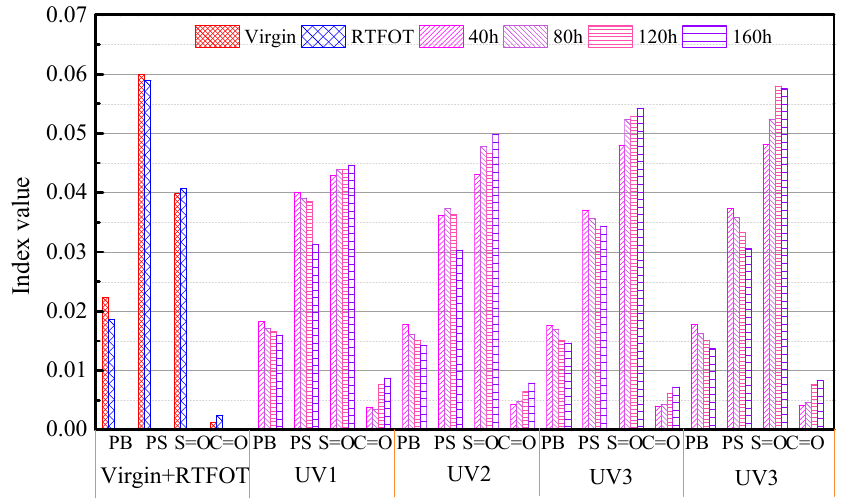
ff erent functional groups in SBS-modified asphalt Figure 8. Aging indices of different functional groups in SBS-modified asphalt binders. Figure 8. Aging indices of di